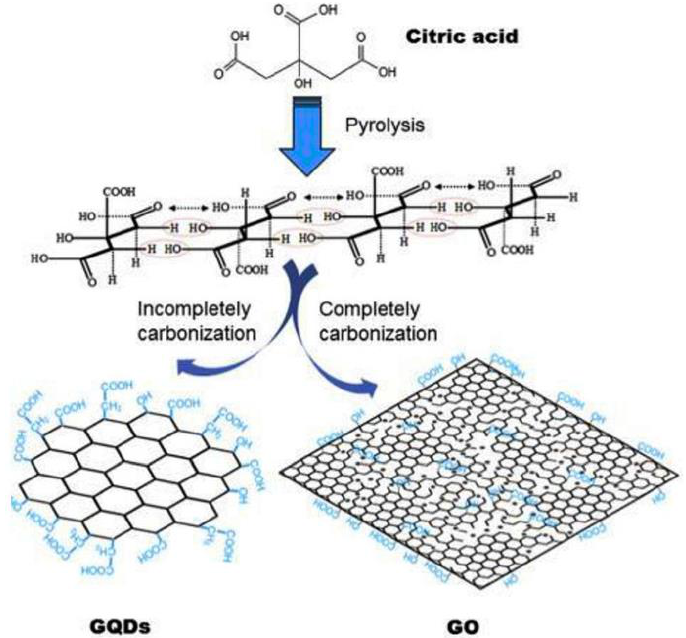
Figure 13. Synthesis of GQDs by carbonization of citric acid, a bottom-up approach. Reprinted from Ref. [46], Copyright (2012), with permission from Elsevier.